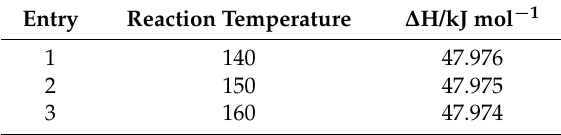
Table 2. The values of ∆ H at different reaction temperatures.